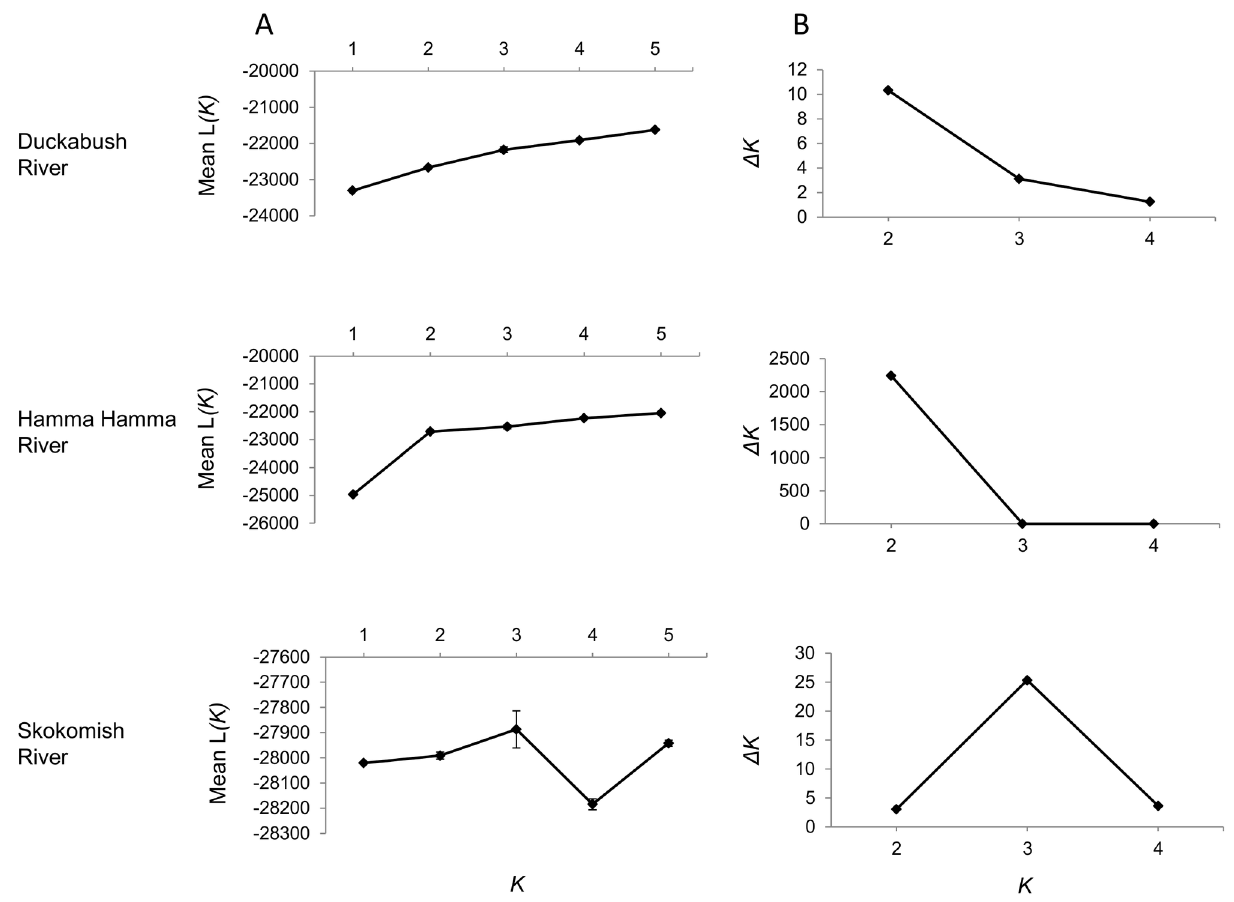
Figure 5. Most likely number of O. mykiss populations ( K ) in three rivers determined from STRUCTURE analyses. The most likely value of K is the one with the greatest rate of change ( ΔK ) between successive L( K ) values. doi: